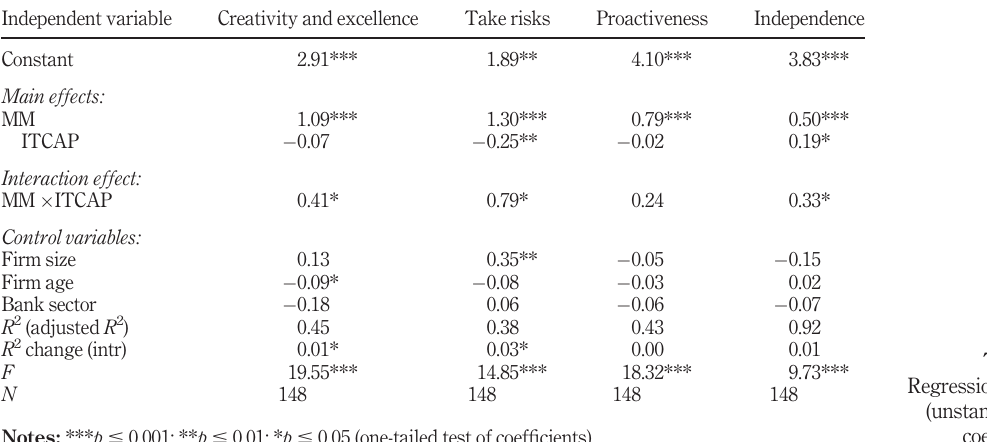
Table 4. Regression